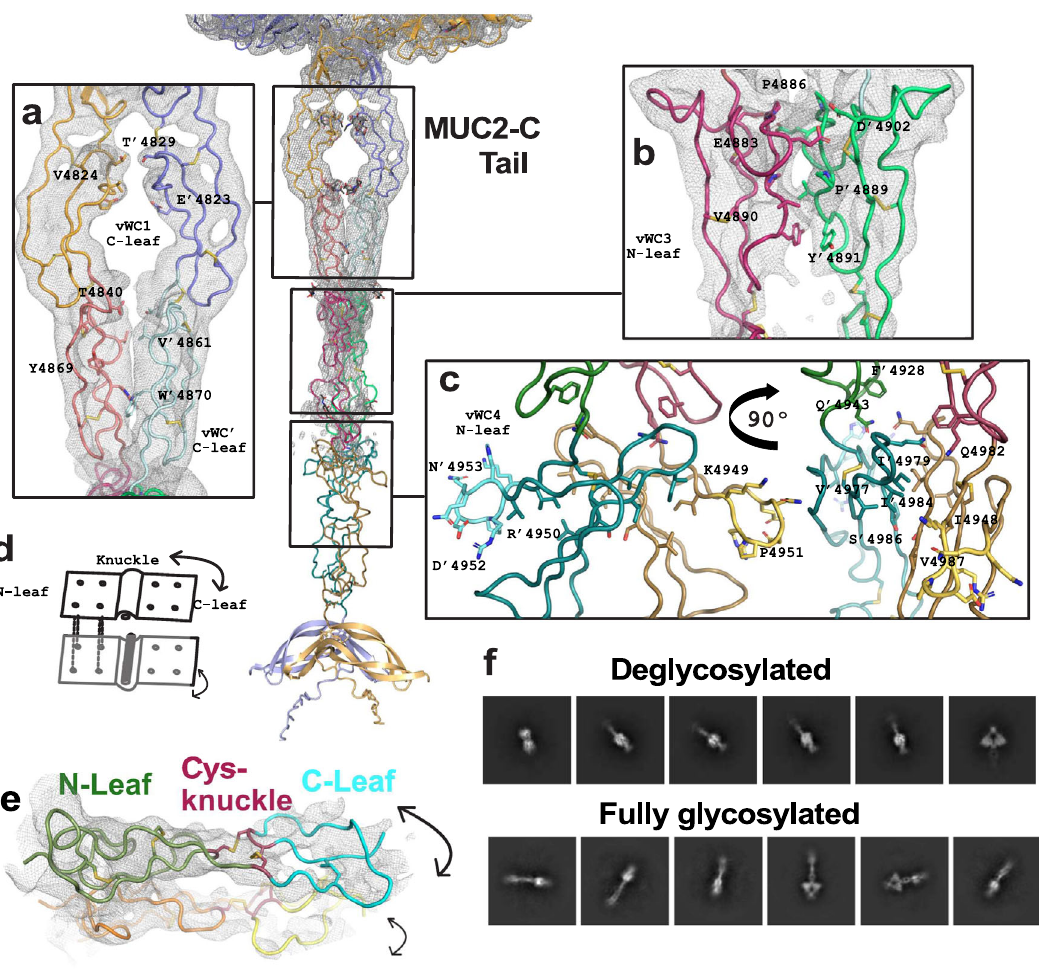
Fig. 3 | The tail region ofthe MUC2-C dimer. TheCryo-EMmaps represented asa grey net. a The dimeric structure formed by the C-Leaf of VWC1 (blue and orange) and VWC ’ (salmon and light cyan) of MUC2-C with the nearby amino acid side chains represented. b The dimeric interface formed by the N-Leaf of VWC3 (magenta and green) with the key amino acid side chains for the interface repre- sented. c The dimeric interface formedby the N-leafof vWC4 (cyanand brown).In the left panel, frontal view of the RPD sequence at the position for the RGD motifs exposed at both sides (cyan and yellow). In the right panel, lateral view of the dimeric interface with key amino acid side chains for the interface represented.